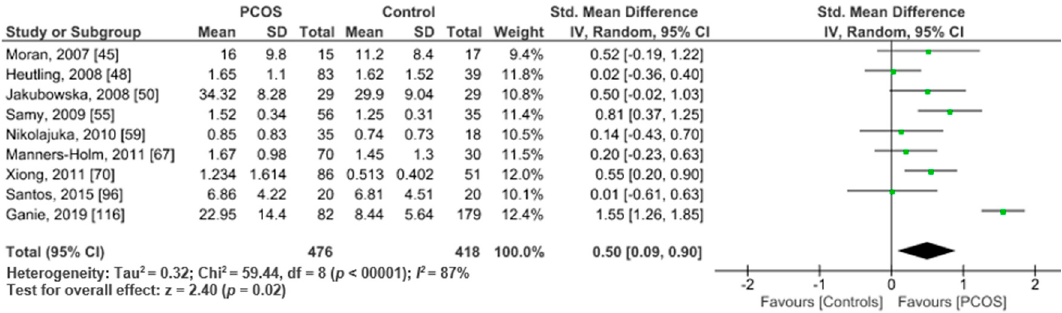
Figure 5. IL-6 metanalysis of 9 studies.